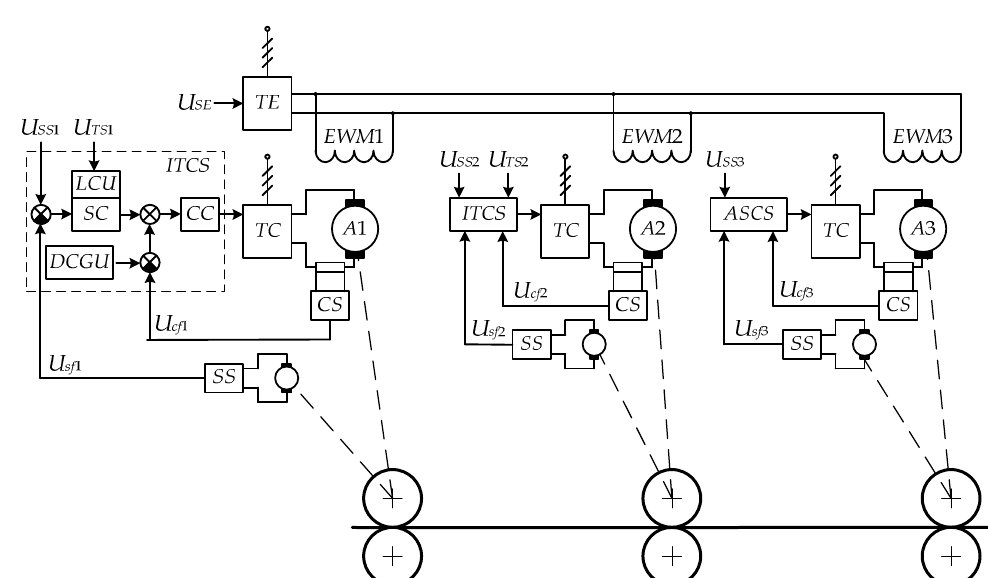
Figure 3. Functional Circuit of the Indirect Tension Control System: A1-A3, EWM1-EWM3:armatures and excitation windings of DC motors; TC: thyristor converter; TE: thyristor exciter; CC, SC: current and speed controllers; CS, SS: current and speed sensors; LCU: limit control unit; DCGU: dynamic current generation unit; ITCS: indirect tension control system; ASCS: automated speed control system; U SSi , U TSi : speed, tension, and excitation current setting voltages; U cfi , U sfi : current and speed feedback voltages.